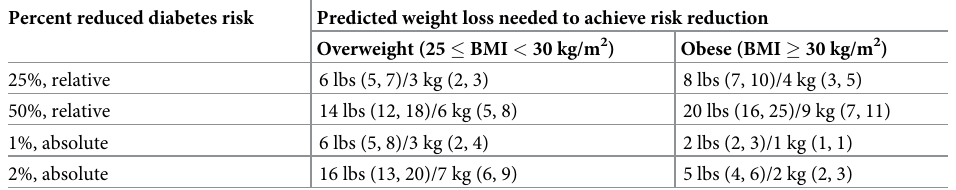
95% confidence intervals are indicated in